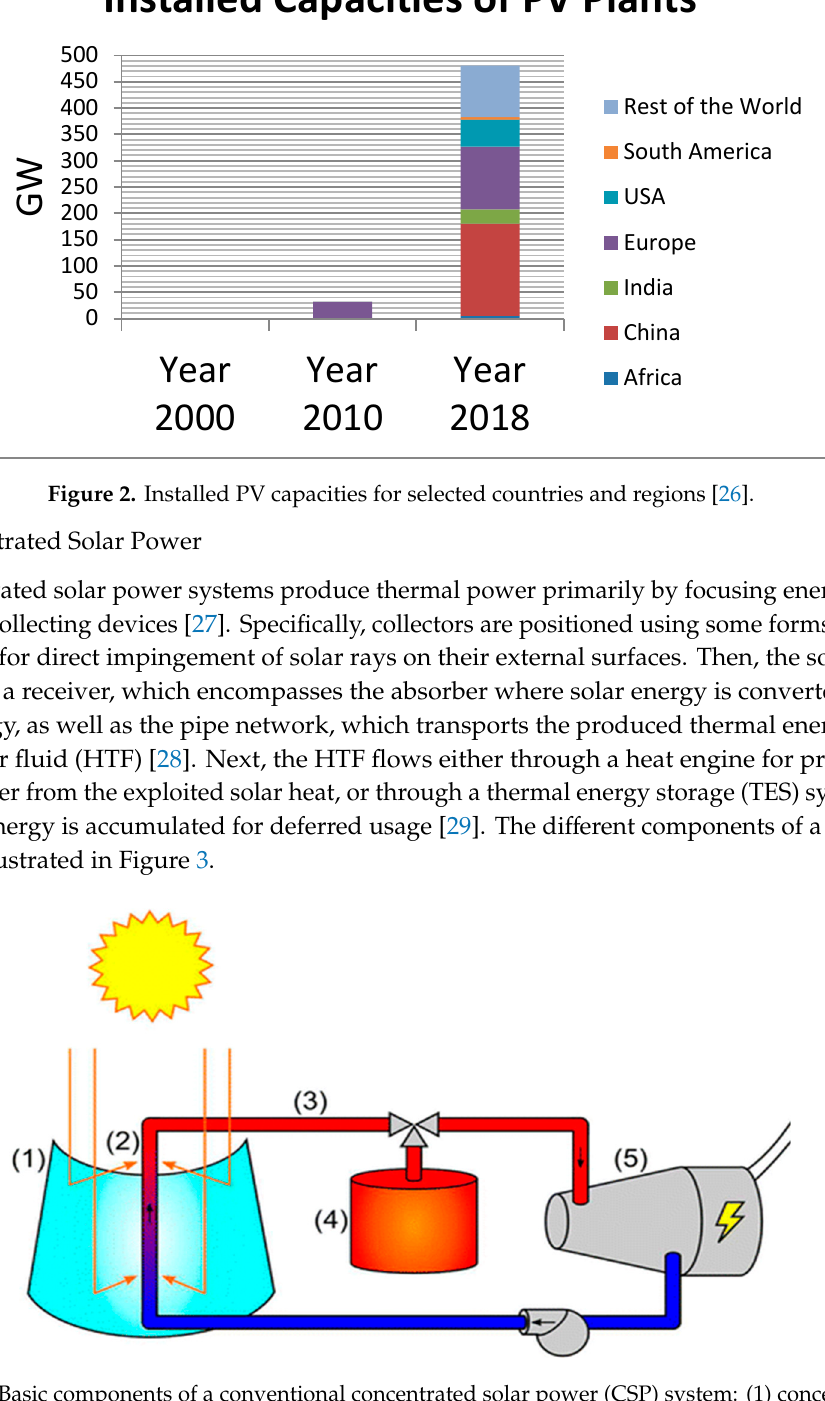
Figure 3. Basic components of a conventional concentrated solar power (CSP) system: (1) concentrator, (2) receiver, (3) heat transfer fluid (HTF), (4) thermal energy storage (TES), and (5) heat engine. Reproduced with permission from [29]. Copyright 2015 American Chemical Society.